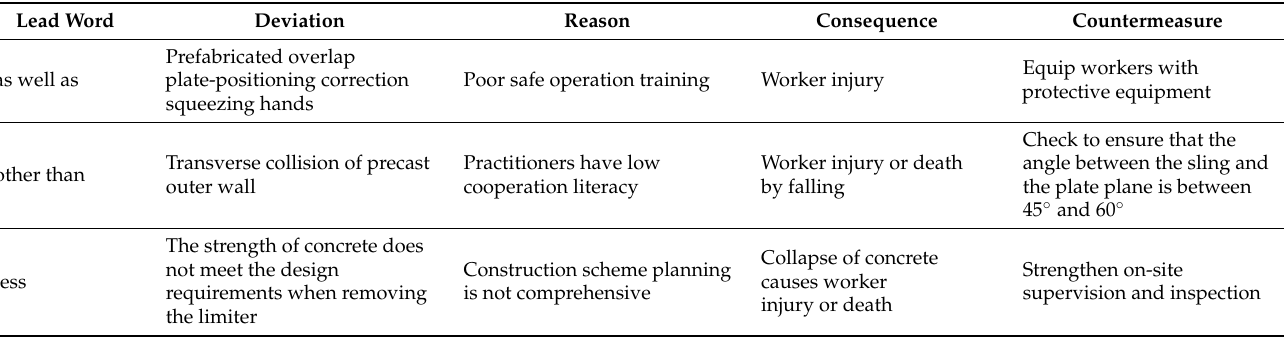
Table 11. HAZOP analysis of the components positioning phase.